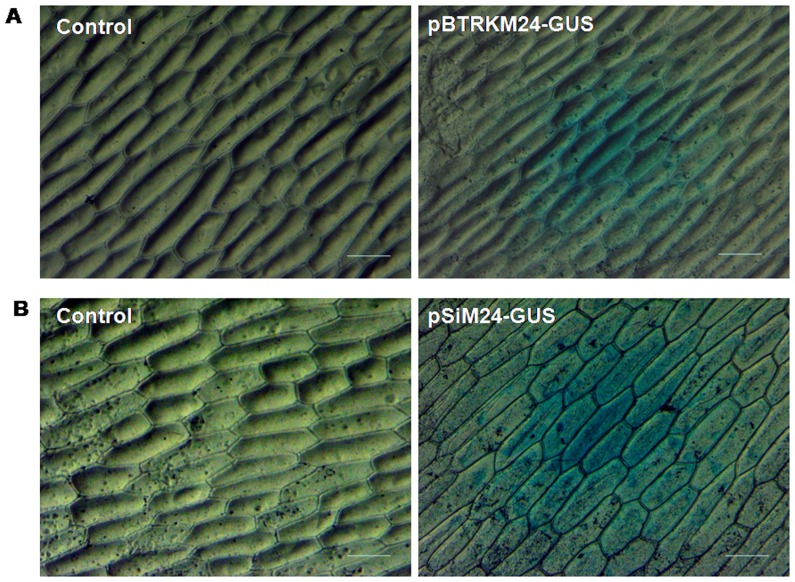
The transient GUS expression analysis of T-DNA assembled fragment of pSiM24 containing GUS and pSiM24-GUS in onion epidermal cells.(A) Light microscopy images of X-gluc-treated onion epidermal cells bombarded with pBTRKM24-GUS (T-DNA assembled fragment of pSiM24 with GUS reporter gene) construct DNA-loaded gold particles are presented. Control represents untransformed onion epidermal cells. These micrographs are representative of data collected after examination of onion epidermal cells from a minimum of four independent experiments. Scale bar, 100 µm. (B) Light microscopy images of X-gluc-treated onion epidermal cells bombarded with pSiM24-GUS (pSiM24 with GUS reporter gene) construct DNA-loaded gold particles are presented. Control represents onion epidermal cells with pSiM24 without GUS reporter gene. These micrographs are representative of data collected after examination of onion epidermal cells from a minimum of four independent experiments. Scale bar represents 100 µm.